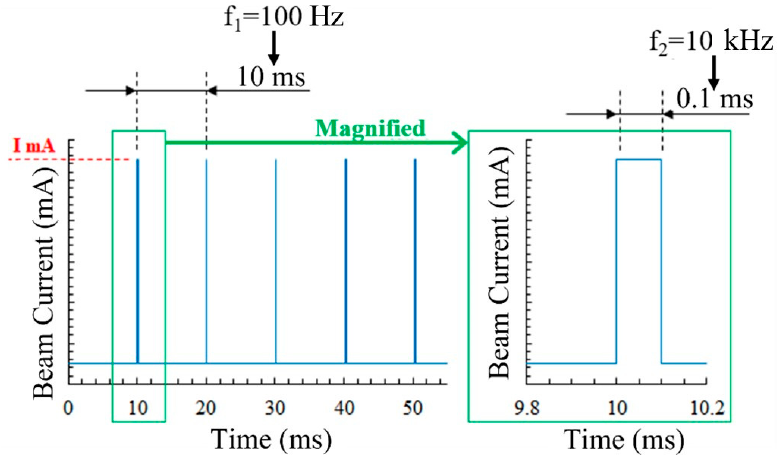
Figure 3. Beam irradiation pattern in smoke detection tests. Table 2. Summary of smoke tests.